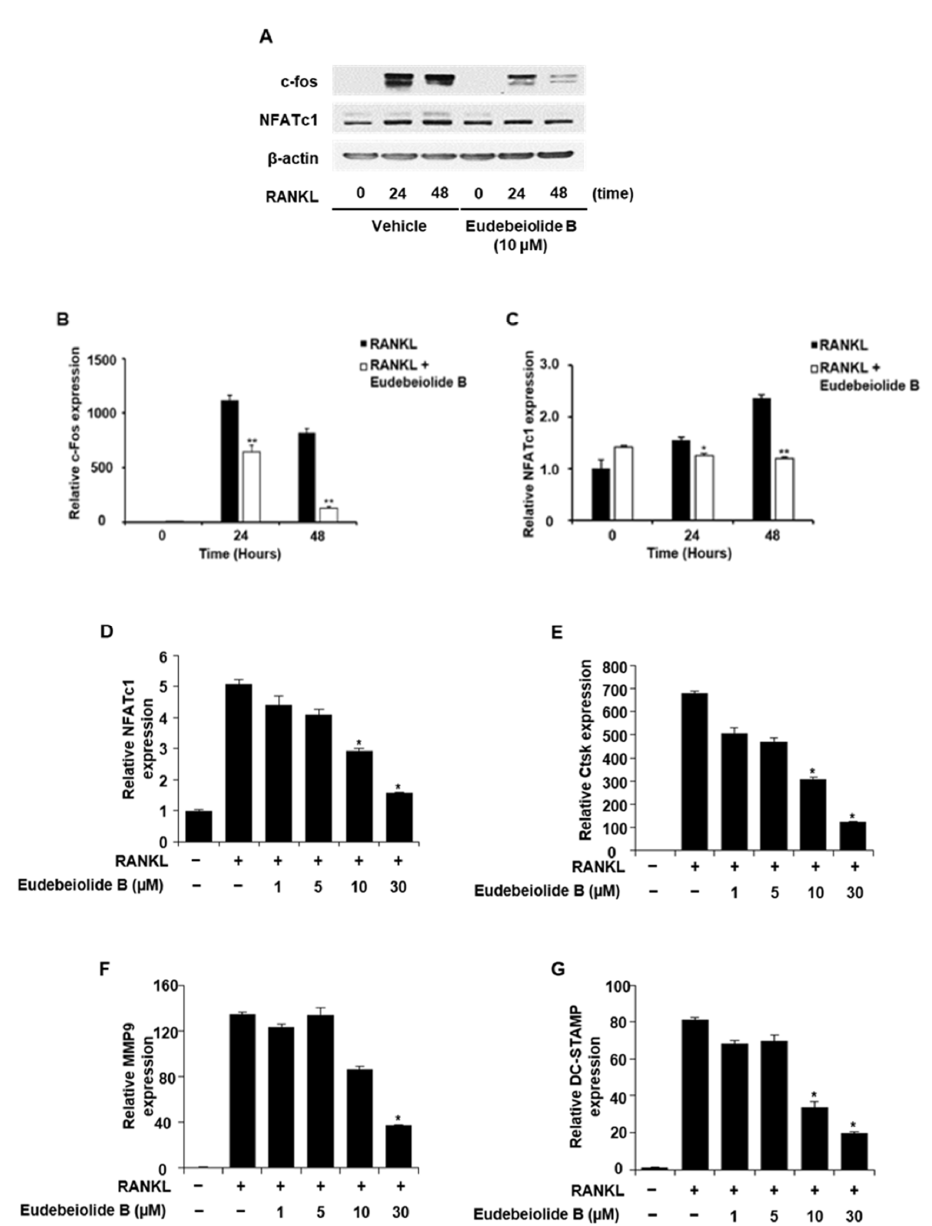
Figure 2. Attenuation of RANKL-induced osteoclastogenesis-related transcription factor and gene expression by eudebeiolide B. ( A – C ) BMMs were pretreated with or without eudebeiolide B and stimulated with RANKL (100 ng/mL) for the indicated time. ( A ) Western blot analysis of c-Fos and NFATc1 protein was performed, and band densities of ( B ) c-Fos and ( C ) NFATc1 were quantified by ImageJ ( n = 3). ( D – G ) BMMs were cultured in the presence of RANKL (100 ng/mL) with or without eudebeiolide B for 48 h. ( D ) NFATc1, ( E ) cathepsin K, ( F ) MMP9 and ( G ) DC-STAMP mRNAs were analyzed by quantitative RT-PCR ( n = 3). All data are expressed as the means ± S.D. of three individual experiments. * p < 0.05 and ** p < 0.01 versus the only-RANKL-treated group ( B , C ) obtained through the unpaired Student’s t -test; * p < 0.05 and ** p < 0.01 versus the only-RANKL-treated group ( D – G ) obtained through one-way ANOVA followed by Dunnett’s test.